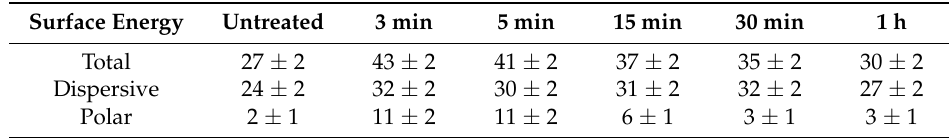
Table 2. Effect of APPT treatment on polydimethylsiloxane (PDMS) surface energy components (mJ·m −2 ) with aging.